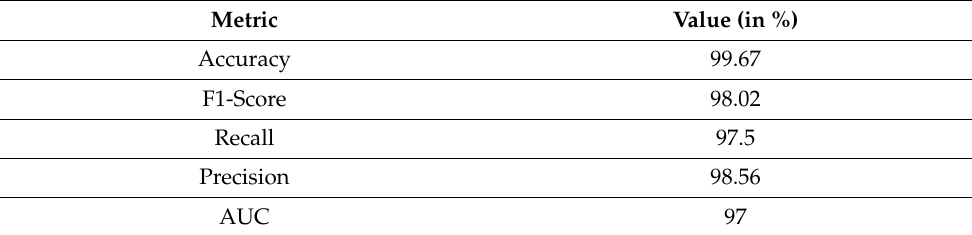
Table 2. Results of classification.